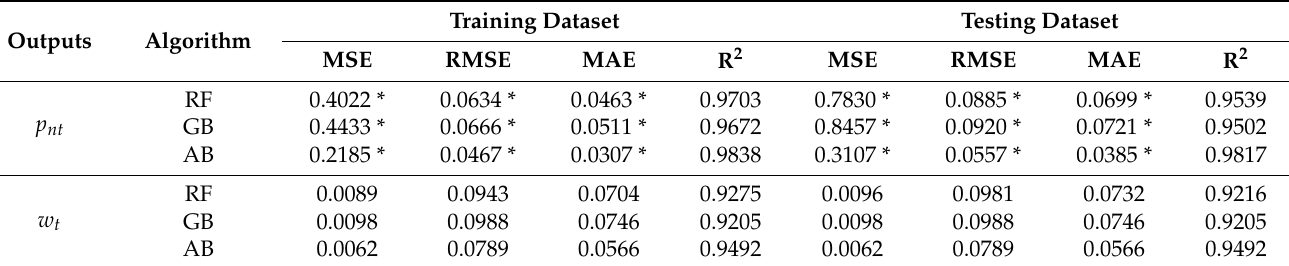
Table 6. Values of measurement performances of ML algorithms for p nt and w t